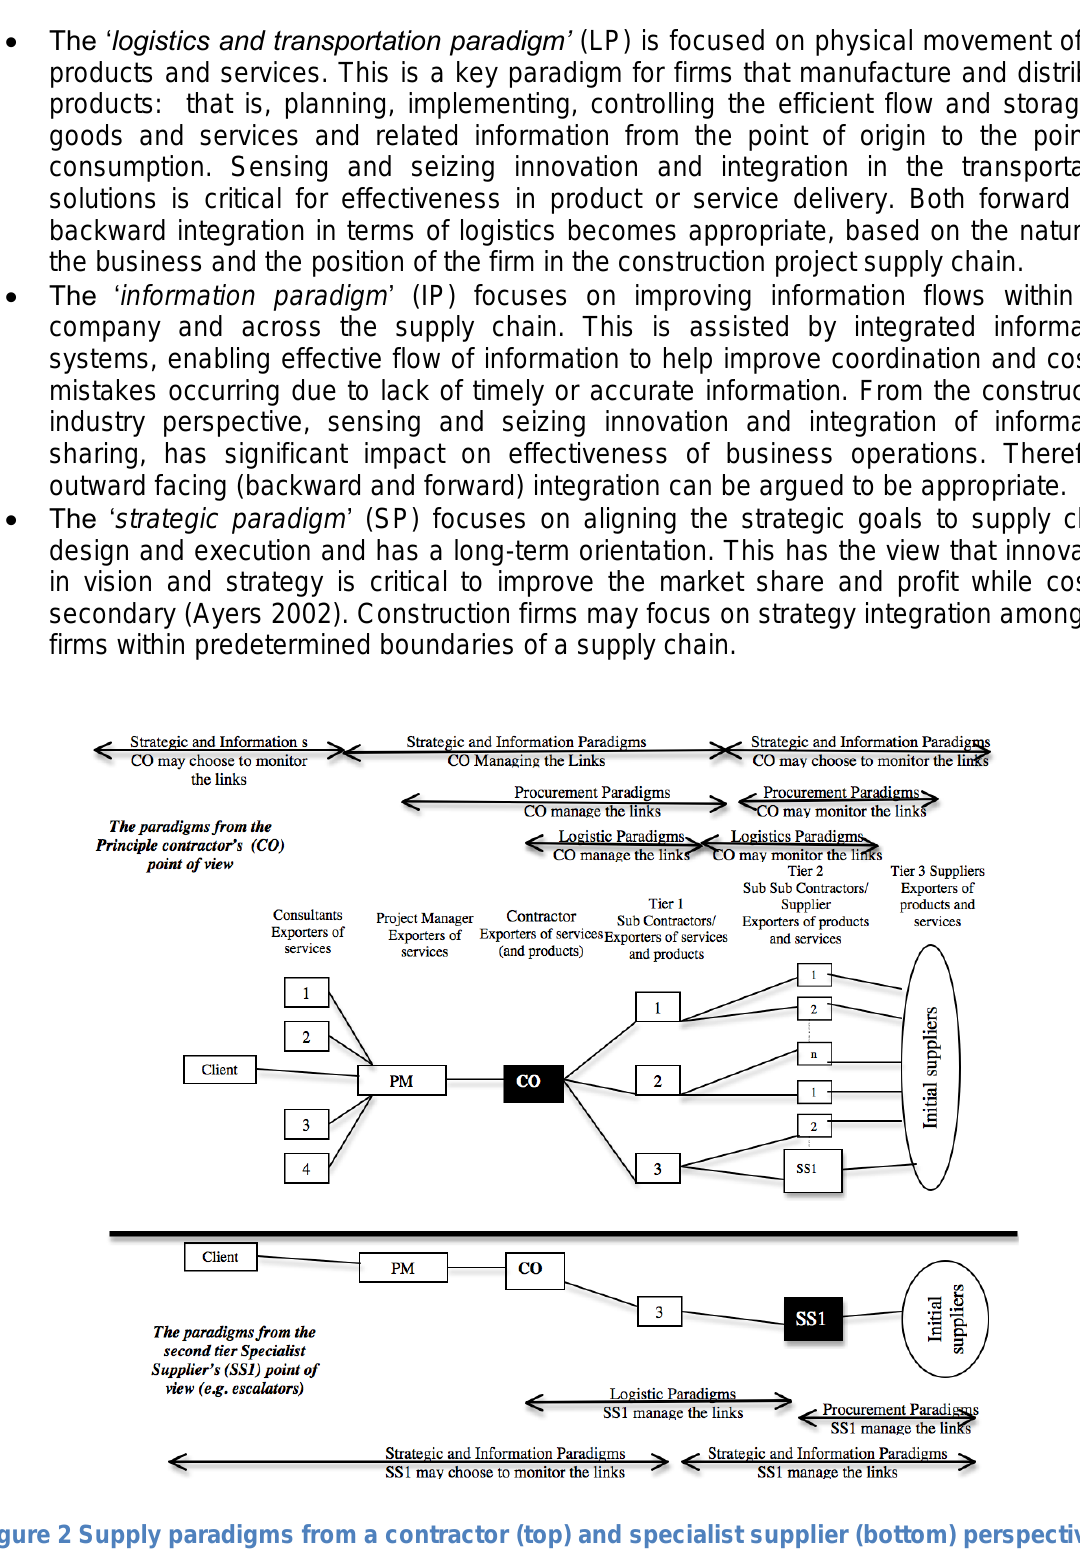
Gajendran, T et al. (2013) ‘Internationalisation of construction business and e-commerce: Innovation, integration and dynamic capabilities’ , Australasian Journal of Construction Economics and Building, 13 (2) 1-17